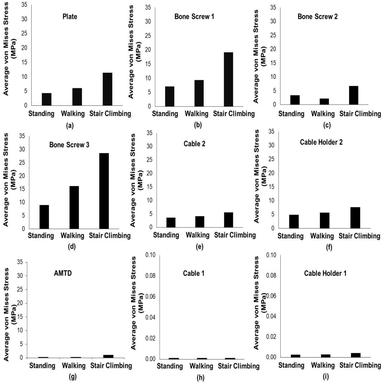
The average equivalent stresses in the (a) plate, (b) bone screw 1, (c) bone screw 2, (d) bone screw 3, (e) cable 2, (f) cable holder 2, (g) AMTD, (h) cable 1, and (i) cable holder 1 of the FE model for standing, stair climbing, and walking condition.